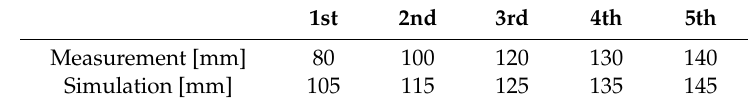
Table 7. Max. Displacement at center line.